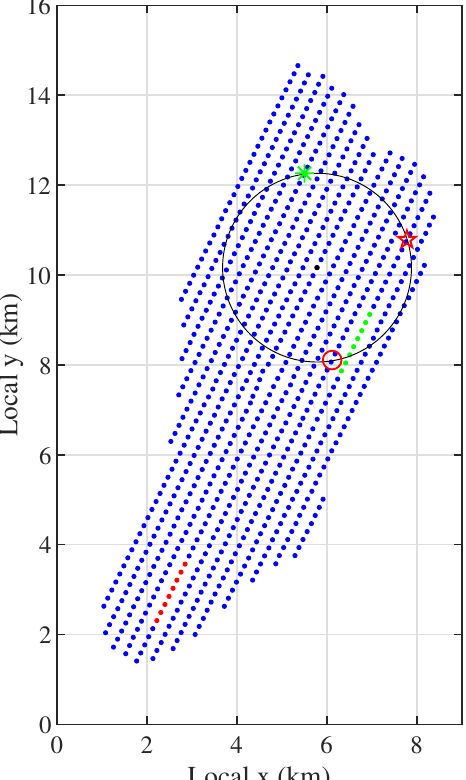
Figure 1. The PRMRA geometry. Not all the receivers are plotted in the figure for display purposes. The gather marked in red is used in the following example of beamforming. The gathers marked in green and red are used in the following examples of the NCC retrieval. The black circle and marks on it are used in the following study of